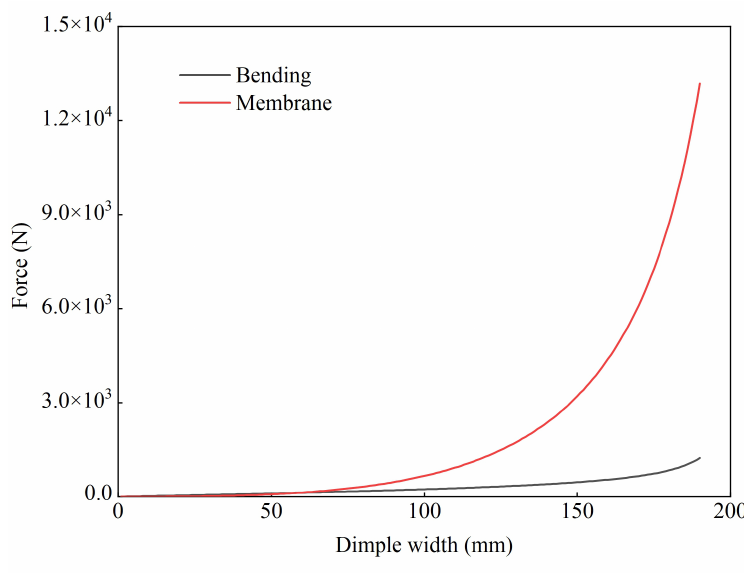
Figure 10. Comparison between general force Q χ ( 3 ) b and Q χ ( 3 ) m